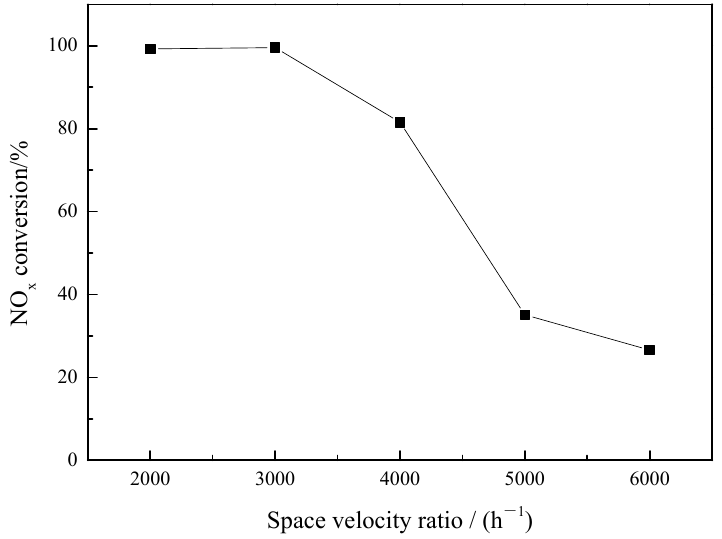
Figure 5. Effect of Space velocity ratio on catalytic reduction of NO in sintered ore.